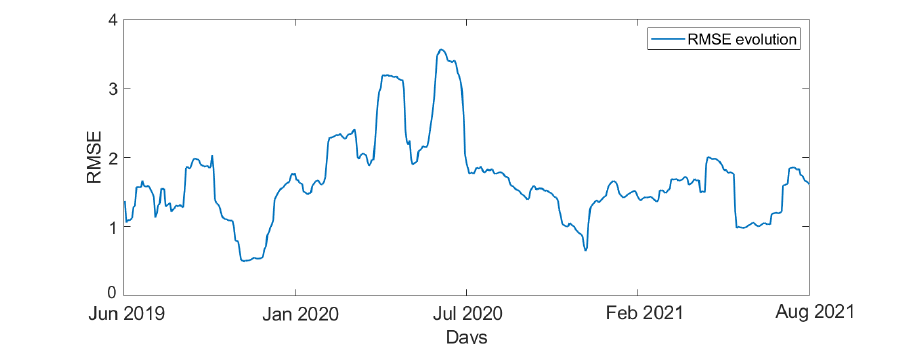
Figure 9. RMSE evolution calculated with a moving window over 20 days in terms of the model’s prediction of the SO 2 emissions at the absorber outlet